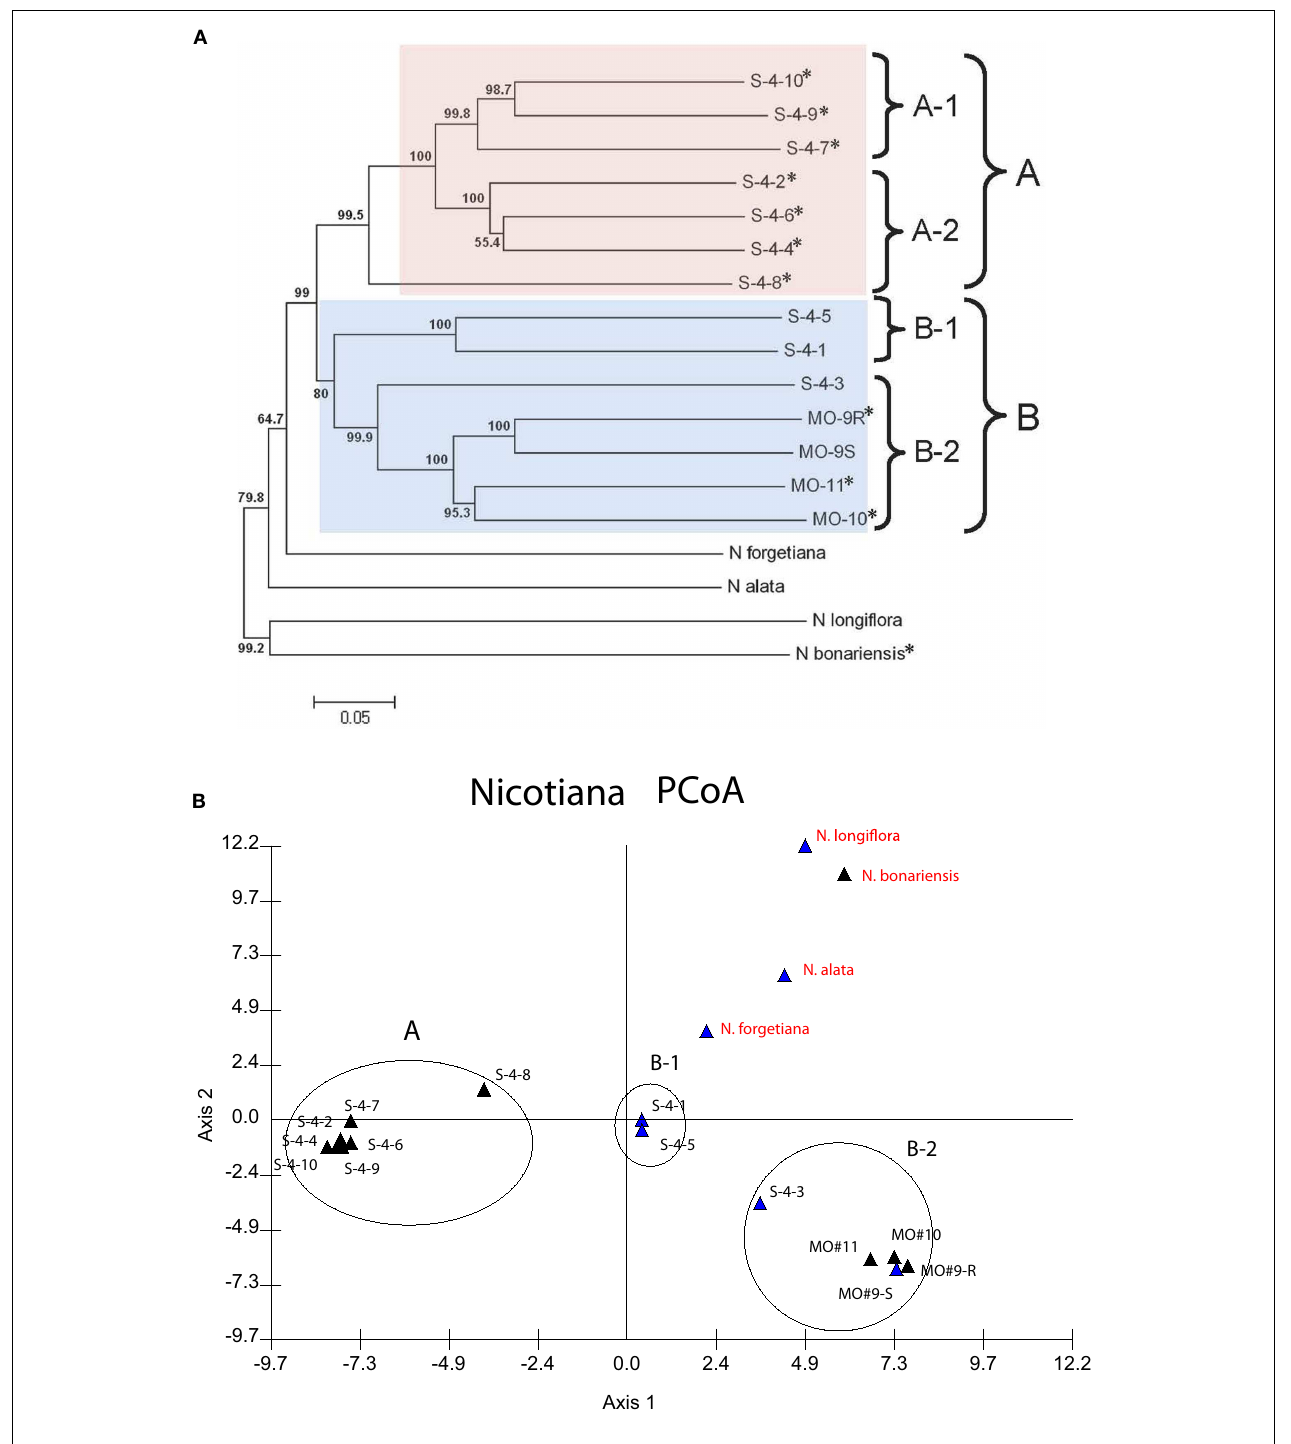
this pathogen. (B) Principal coordinates analysis (PCoA) of the AFLP data for Nicotiana section Alatae .The first two orthogonal axes explain 34.183% of the total variation. Clusters A, B-1, and B-2 correspond to the clusters present in the N-J tree. All accessions of N. langsdorffii are labeled in black, while the other species in sect. Alatae are shown in red. Accessions that are either susceptible or resistant to P. tabacina infection are indicated by blue and black triangles,